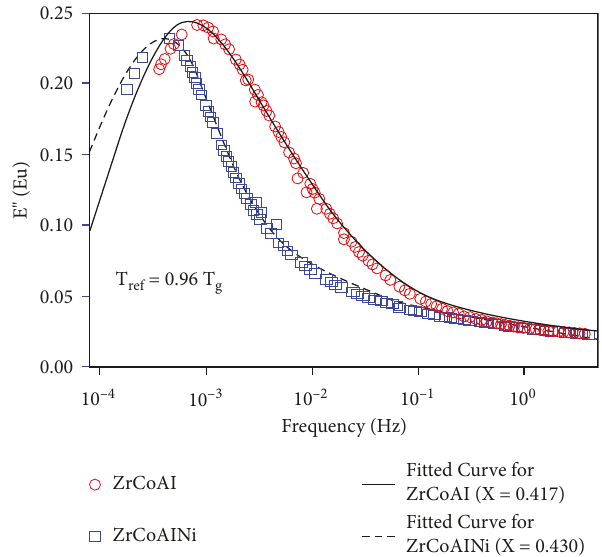
Figure 8: Master curves of ZrCoAl and ZrCoAlNi MGs fitted by the QPD equation.